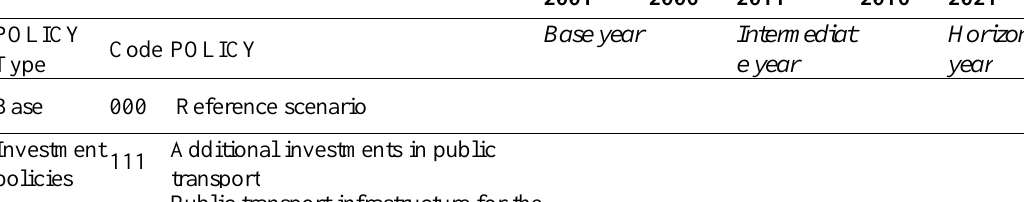
Table 3. Policies evaluated in the Dortmund urban